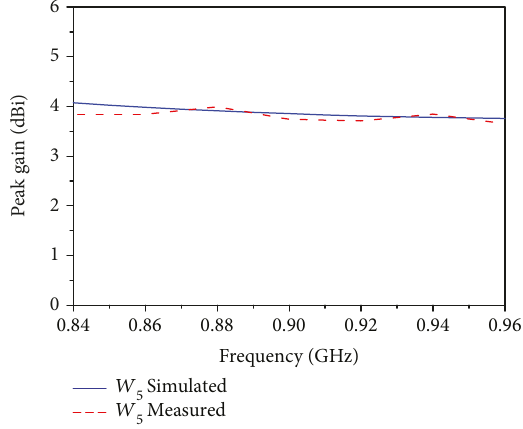
11 and (b) AR results of Antenna 4.